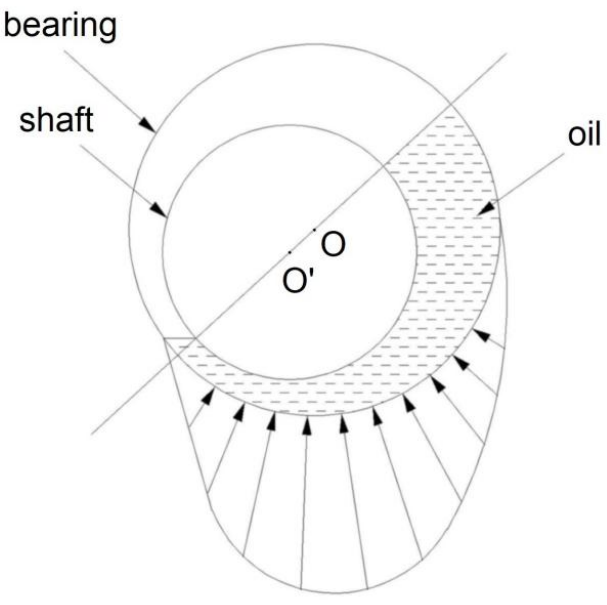
Figure 1. Schematic diagram of hydrodynamic lubrication.